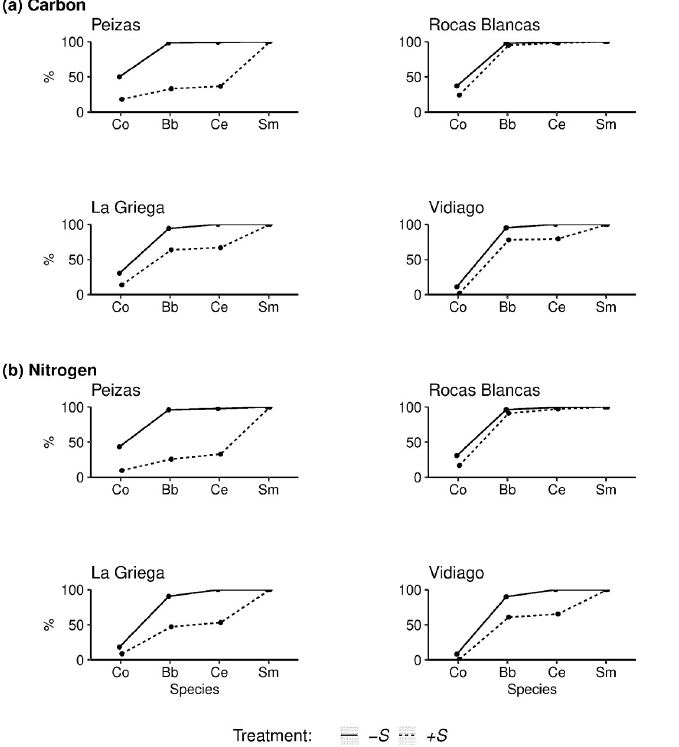
Fig 4. Cumulative contribution to carbon and nitrogen pools. Average percentage mg of 13 C-carbon (a) and of 15 N- nitrogen (b) of the native species (Co = Corallina spp., Bb = Bifurcaria bifurcata , Ce = Ceramium spp.) and of the invader Sargassum muticum (Sm) in control (+S) and S . muticum— removed (-S) rock pools at each